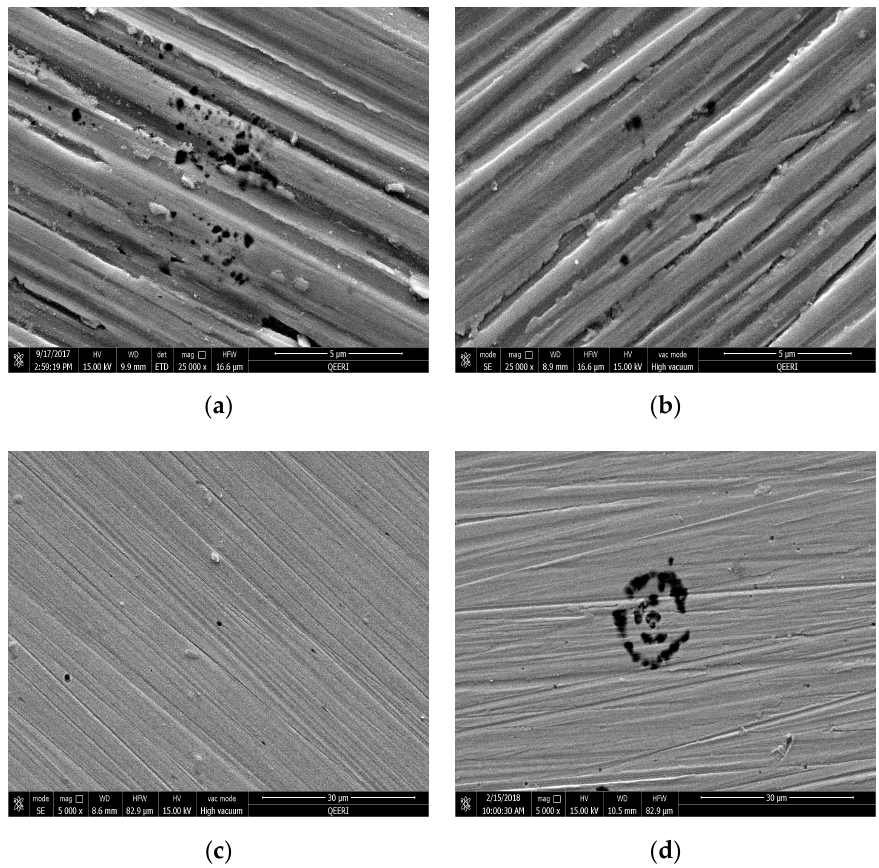
Figure 10. SEM images for 316L stainless steel samples after the potentiodynamic testing in different solutions: ( a ) tap water, ( b ) deionized water, ( c ) 1.5 wt% GA-water and ( d ) 3.5 wt% NaCl solution.